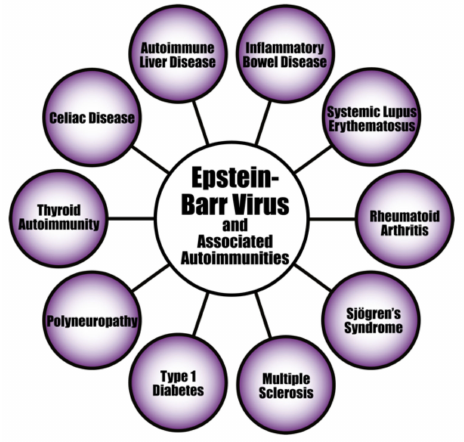
Figure 8. Epstein–Barr virus and a few of its associated autoimmune